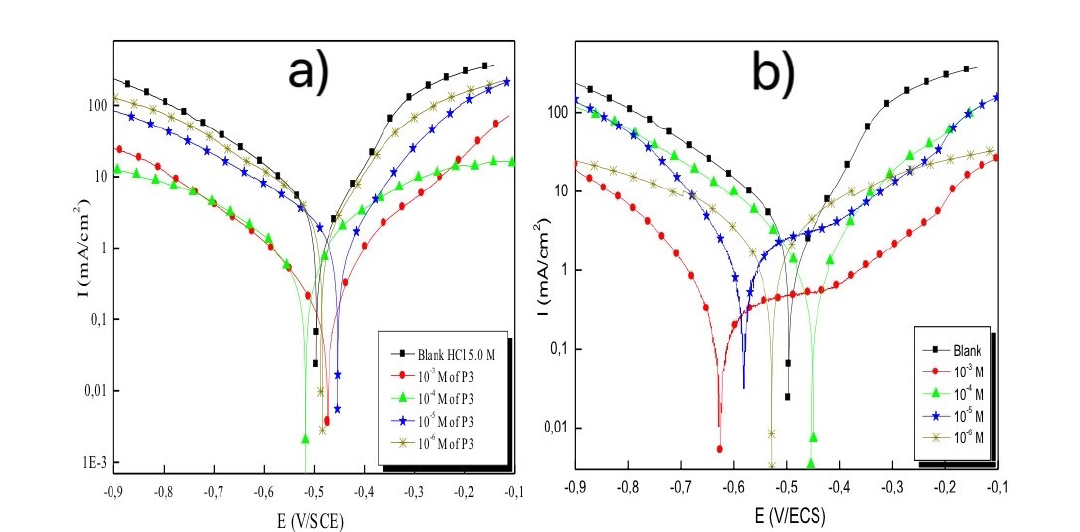
Figure 2. Tafel polarization curves for ordinary mild steel obtained in 5.0 M HCl solution containing different concentrations at 298 K of (a) P3 or (b)